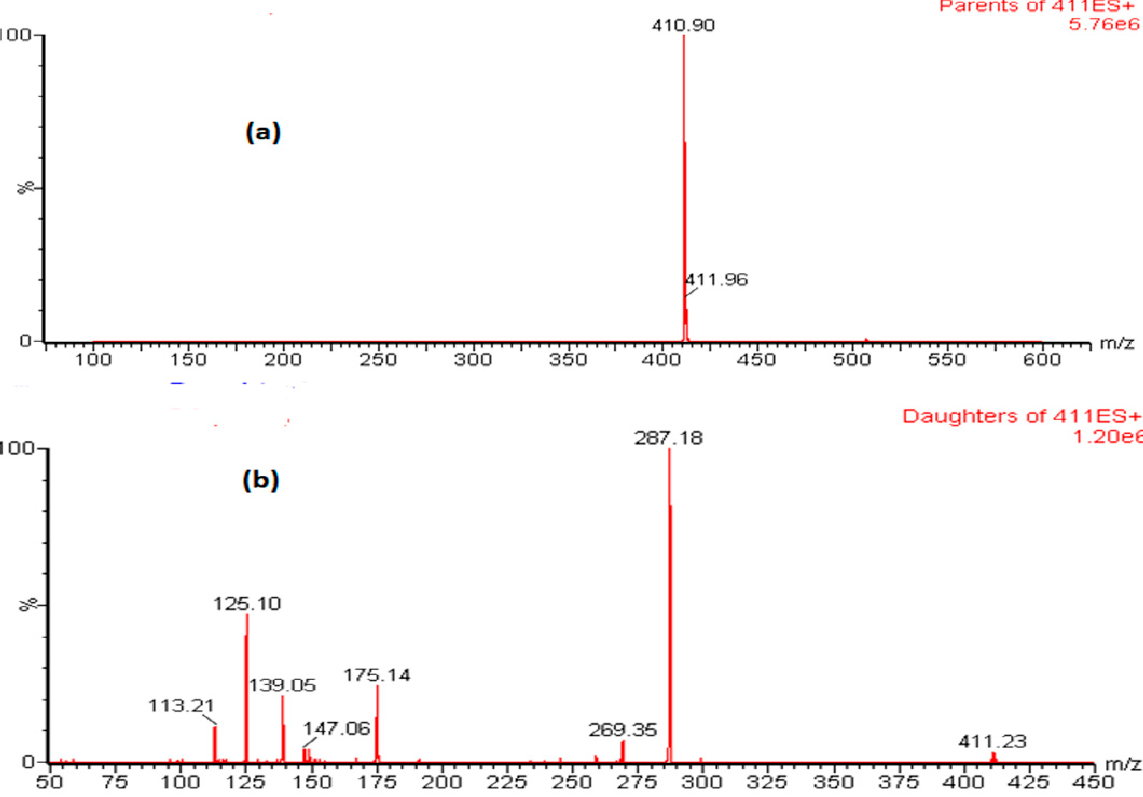
Figure 2. Representative LEM mass spectra of precursor ion ( a ) and precursor to product ion ( b ) in ESI positive mode.